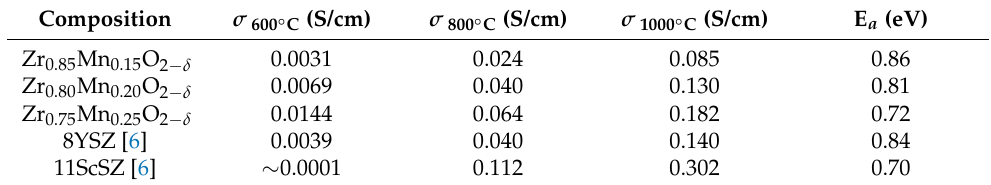
Table 1. Specific conductance at different temperatures and activation energy values for Zr 1 − x Mn x O 2 − δ , 8YSZ and